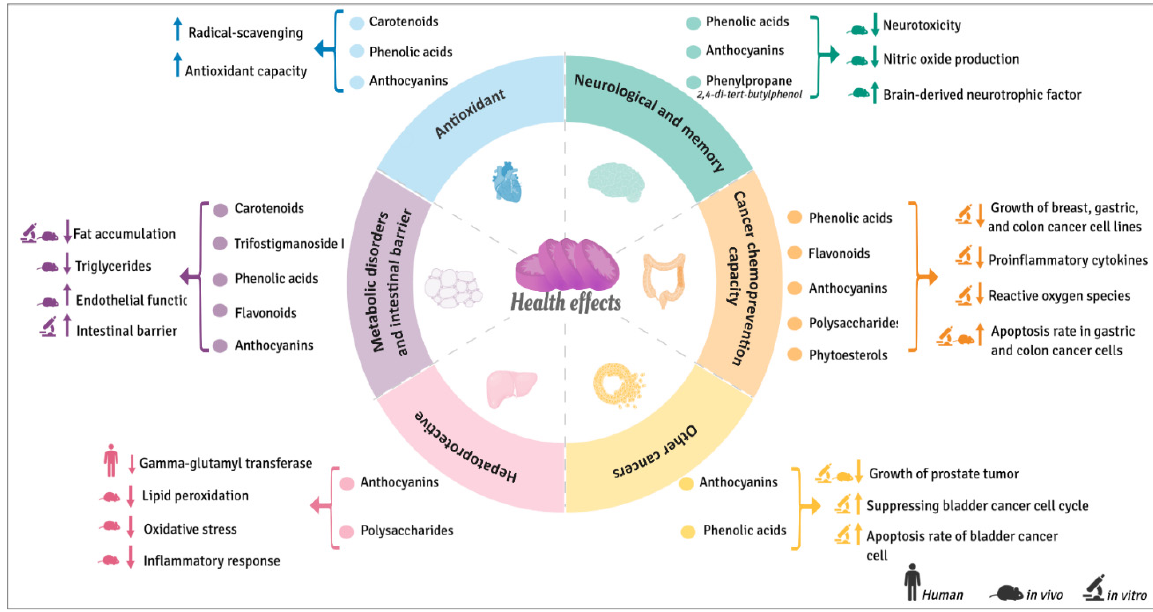
Figure 6. Beneficial health effects of bioactive compounds from sweet potatoes.